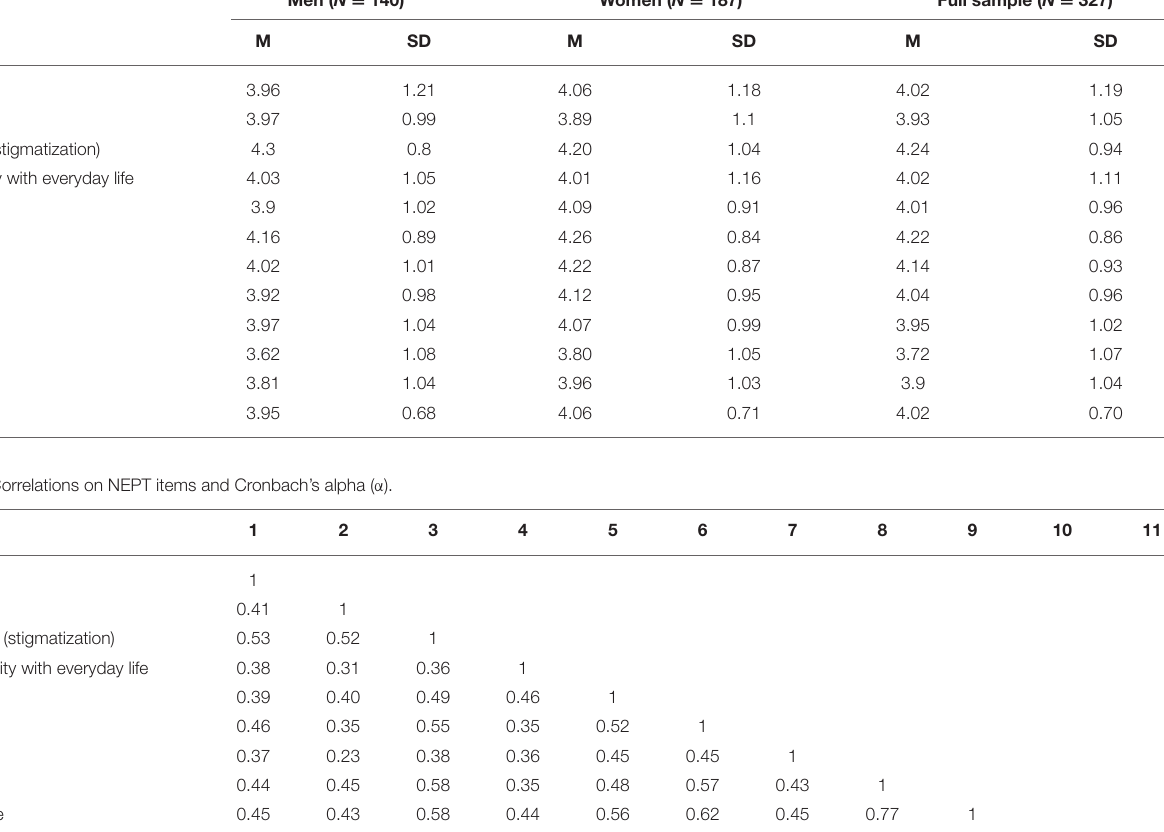
TABLE 1 | Mean scores of NEPT items and total score.